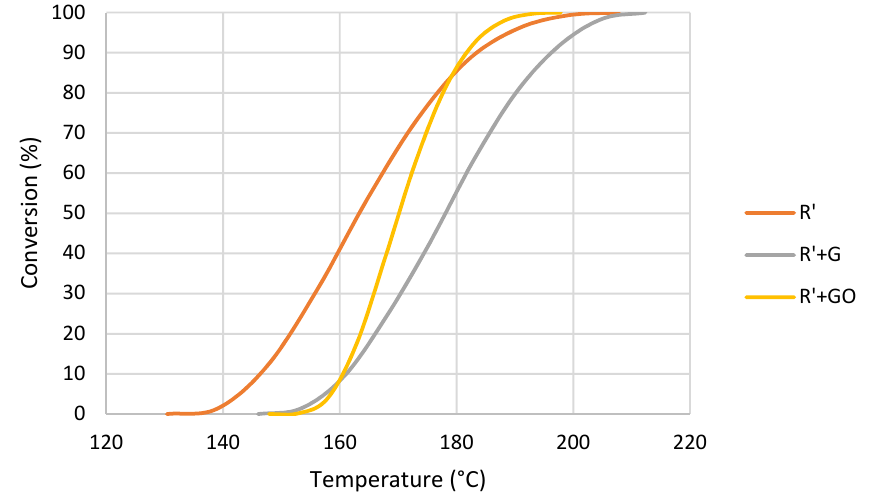
Figure 7. Conversion curves at 10 °C/min of R’ and R’+GBN.